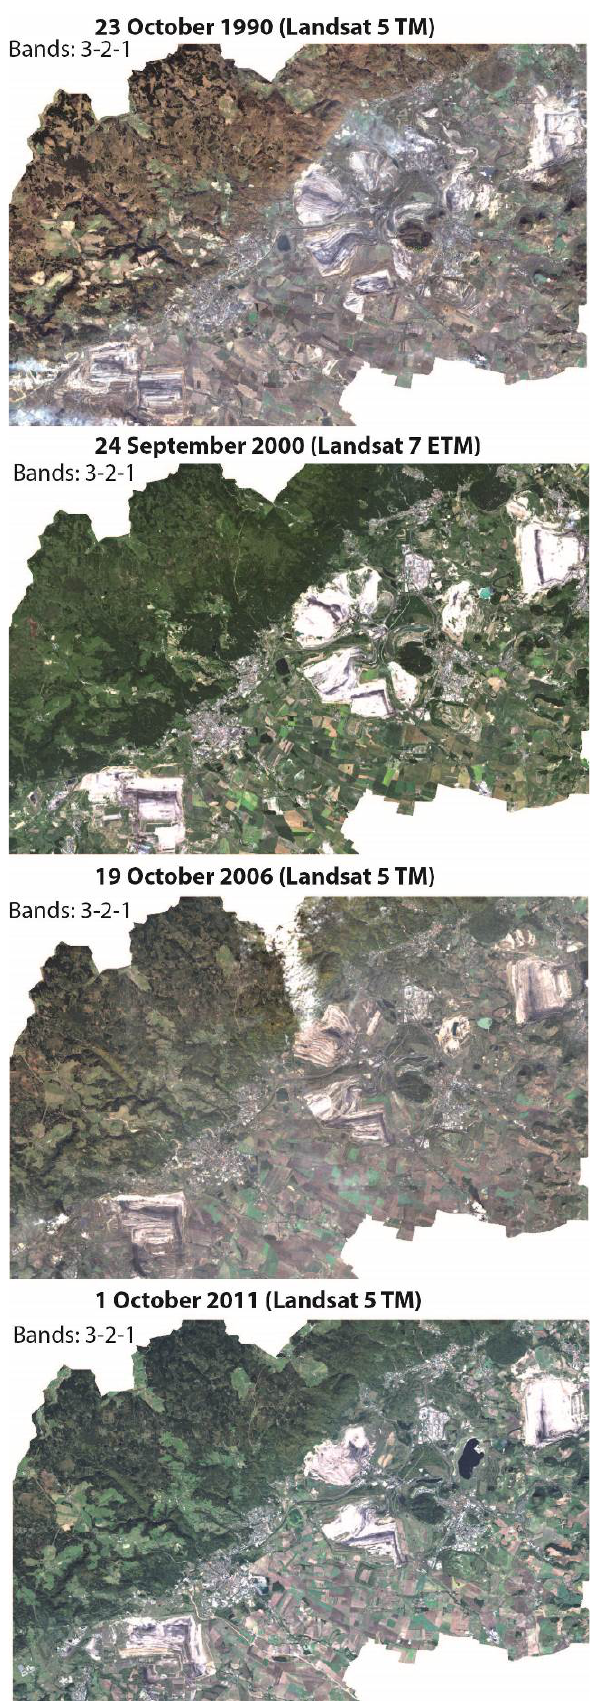
Figure 2. Multispectral images: 1990 Landsat 5 TM, 2000 Landsat 7 ETM+, 2006 Landsat 5 TM and 2011 Landsat 5 TM.